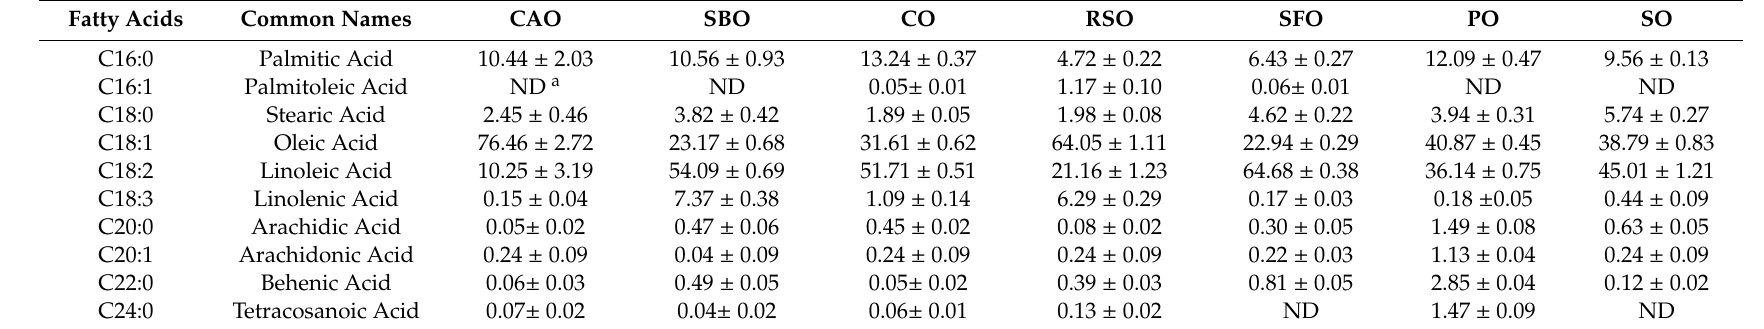
Table 2. Major fatty acid composition of oil samples analyzed using gas